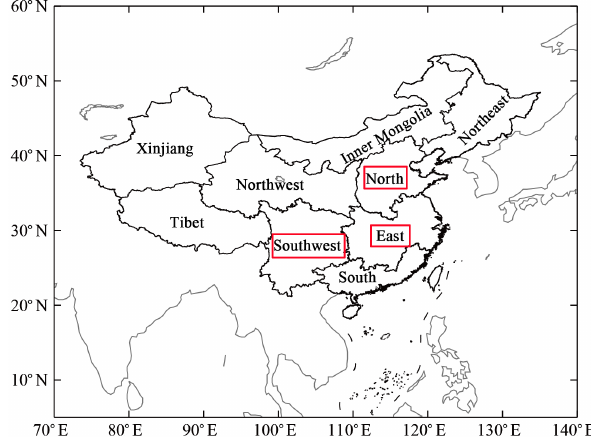
Figure 2. The geographical distribution of China’s nine drought re- gions (black solid curves). The three regions labeled with red boxes are the focus in the present